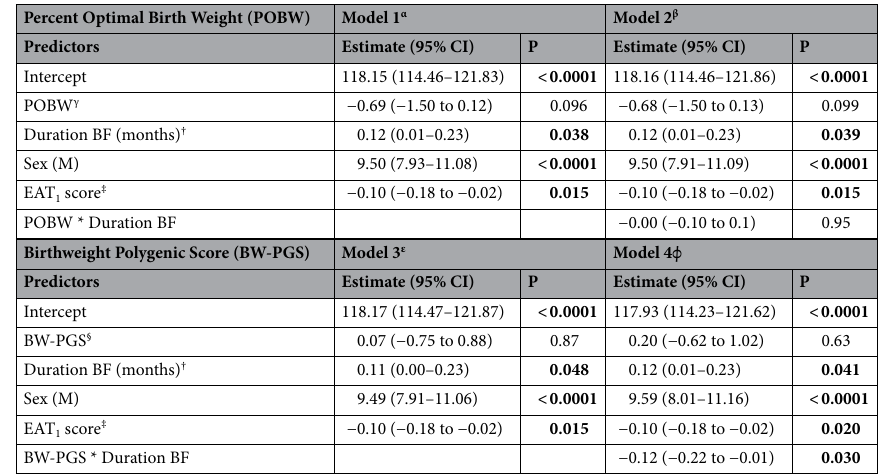
Table 3. Association analyses for systolic blood pressure (mmHg). γ POBW = Percent Optimal Birth Weight (standardised); † Duration of BF = Duration of any breastfeeding (mean-centred); ‡ EAT 1 score = quality of early life nutrition in first year of life; § BW-PGS = birth weight polygenic score (standardised); δ adjustment for population stratification; α Model 1 examines the effect of duration of breastfeeding adjusting for POBW, sex and EAT 1 score; β Model 2 examines the effect modification of duration of breastfeeding by POBW adjusting for sex and EAT 1 score; ε Model 3 examines the effect of duration of breastfeeding adjusting for BW-PGS, sex, EAT 1 score and the first two principal components [PCs] (estimates not presented); effect modification of duration of breastfeeding by BW-PGS adjusting for sex, EAT 1 score and the first two principal components [PCs] (estimates not presented).